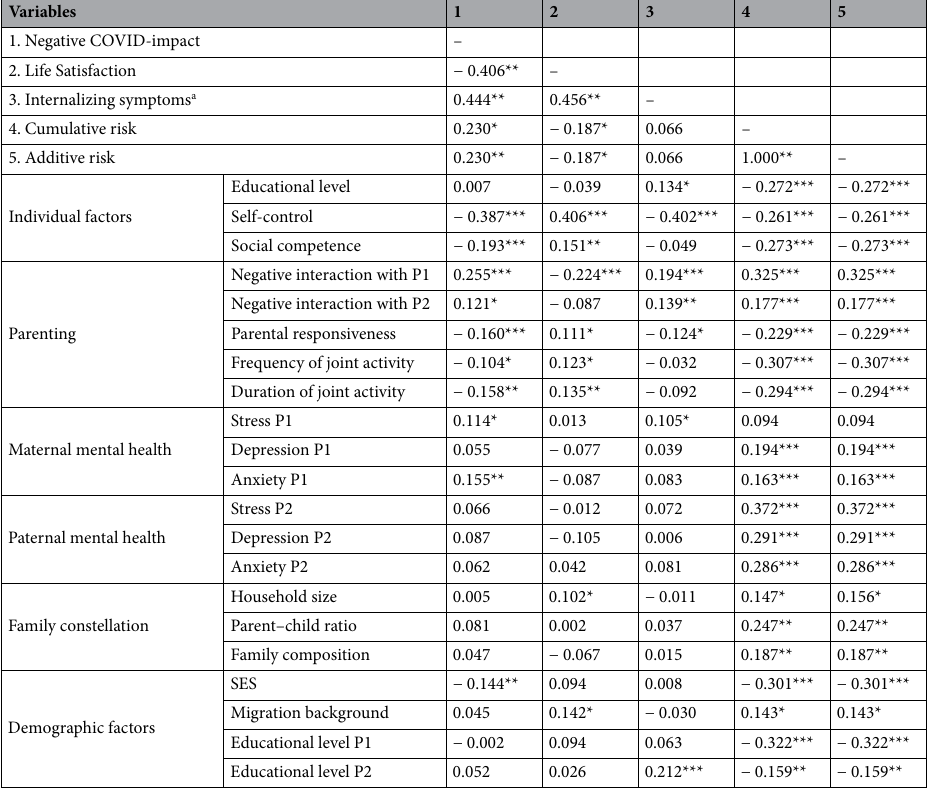
Table 2. Spearman correlations for youth reported (outcome) variables (1–5) and correlations for outcome variables with risk factors. Asterisks signify significant effects, * p < 0.05, ** p < 0.01 & *** p < 0.001. a Recoded (1 = no symptoms, 2 = mild symptoms, 3 = moderate symptoms, 4 = severe symptoms).